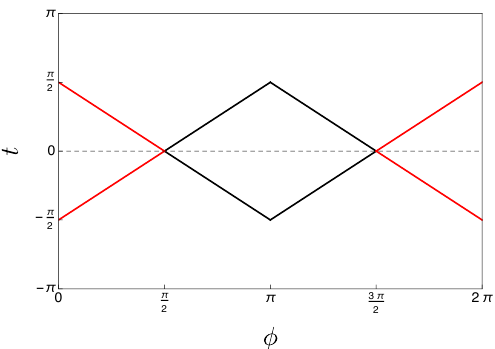
Figure 5. Boundary diamonds for the BTZ black hole, where φ ∼ φ + 2 π . As we can see, there are two diamonds, each containing one asymptotic boundary of the fundamental